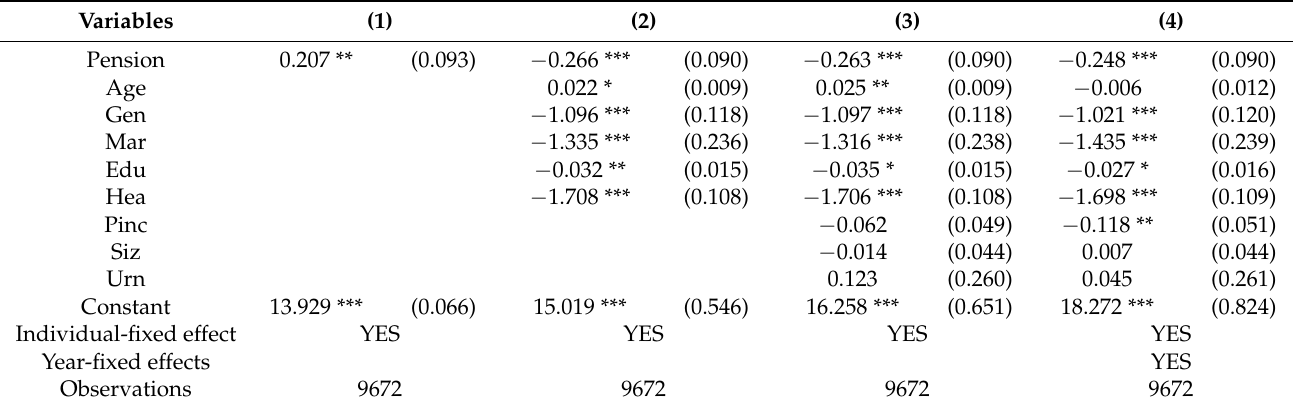
Table 2. Basic regression results.